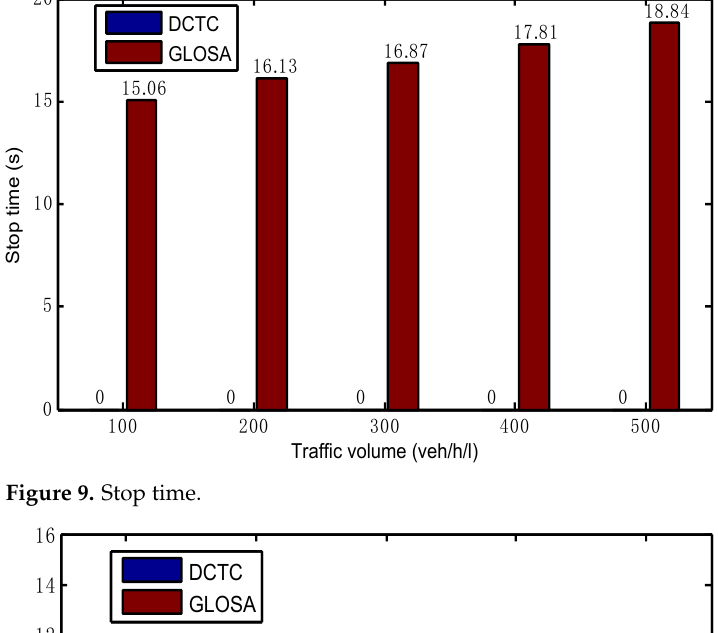
Figure 9. Stop time.